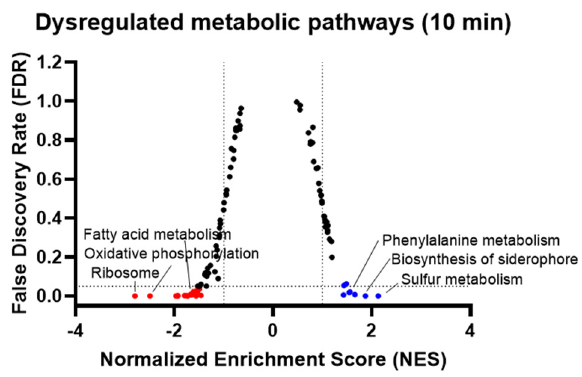
Figure 5. Dysregulated metabolic pathways 10 min after H 2 O 2 addition, determined using gene set enrichment analysis. Each dot represents a metabolic pathway from the KEGG database; thresholds: FDR = 0.05, NES (normalized enrichment score) >1 and < − 1.